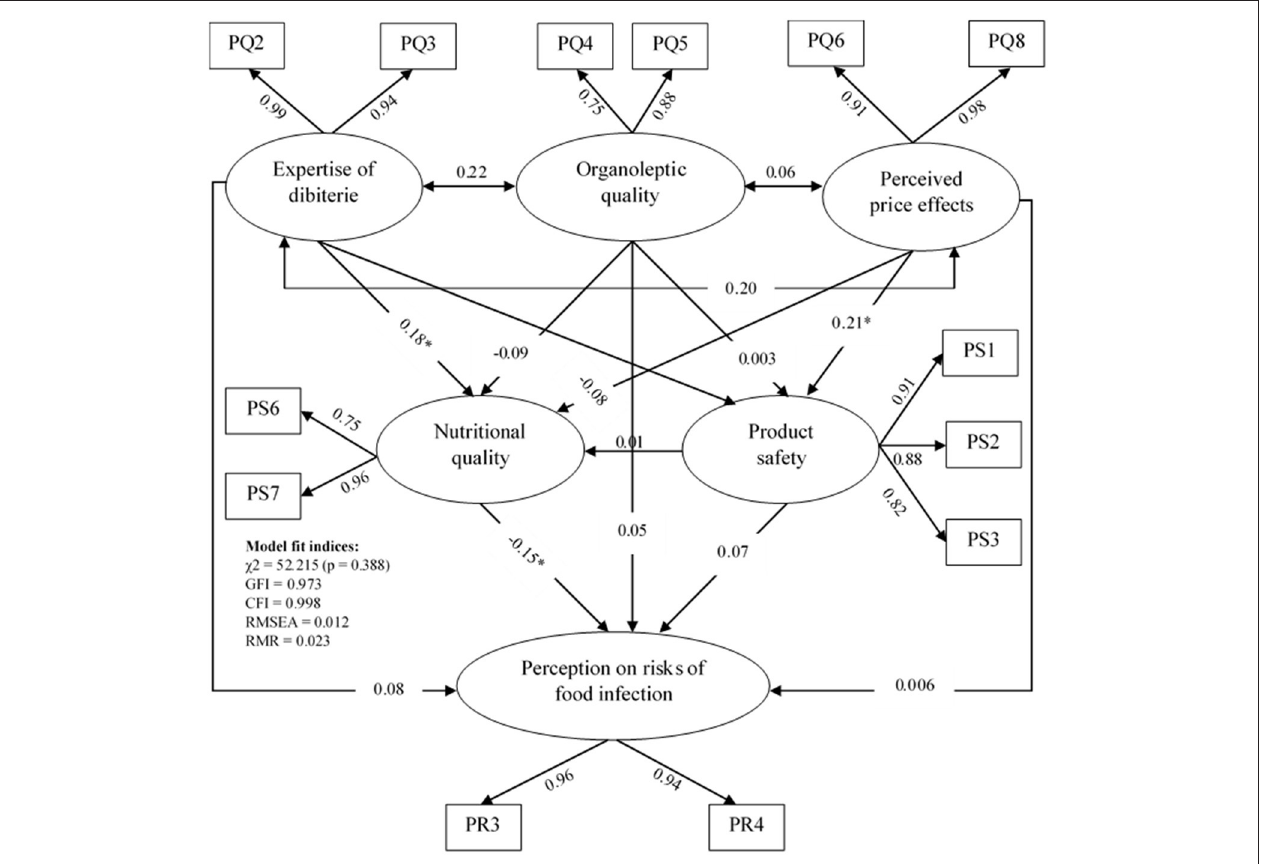
FIGURE 2 | Estimates of the final standardized model of the relationships between the latent variables of the perception on the quality, the perception on the safety of dibiterie meat, and the perception on the risks of food infection (PQ, Perception on the quality; PS, Perception on the safety; PR, Perception on the risks) ( n = 291). *The value of standardized coefficients that are